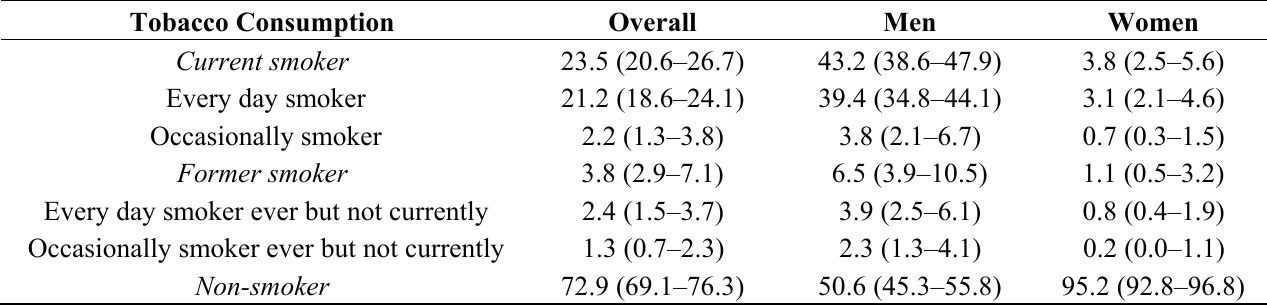
Table 1. Prevalence of tobacco consumption among residents in Changchun, weighted prevalence